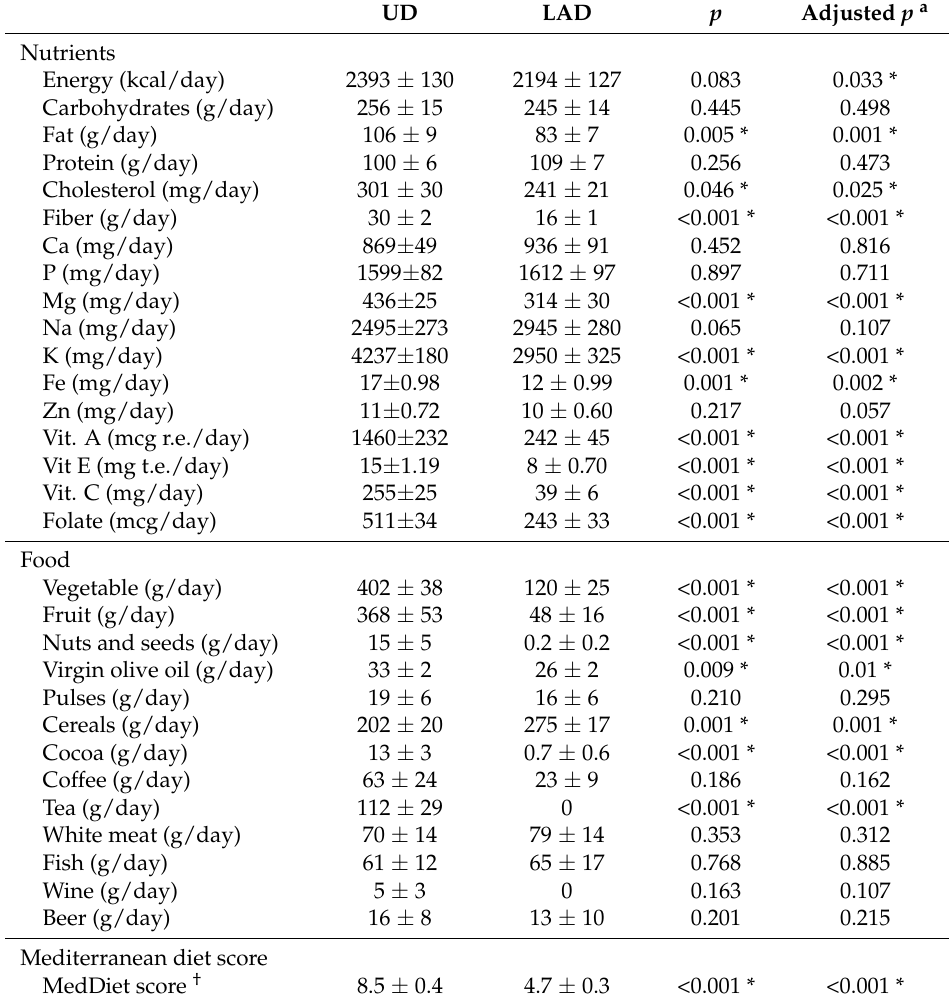
Table 2. Changes in the dietary parameters after 2